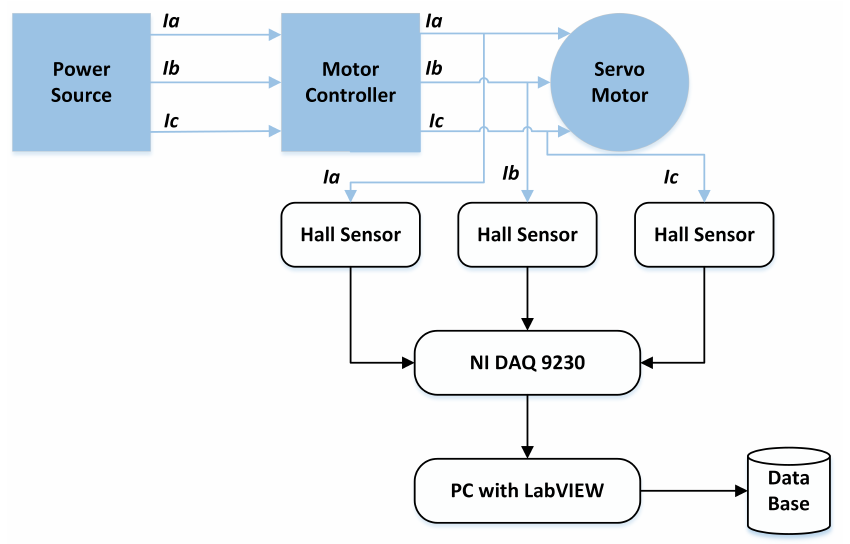
Figure 8. Basic overview of the data acquisition process.